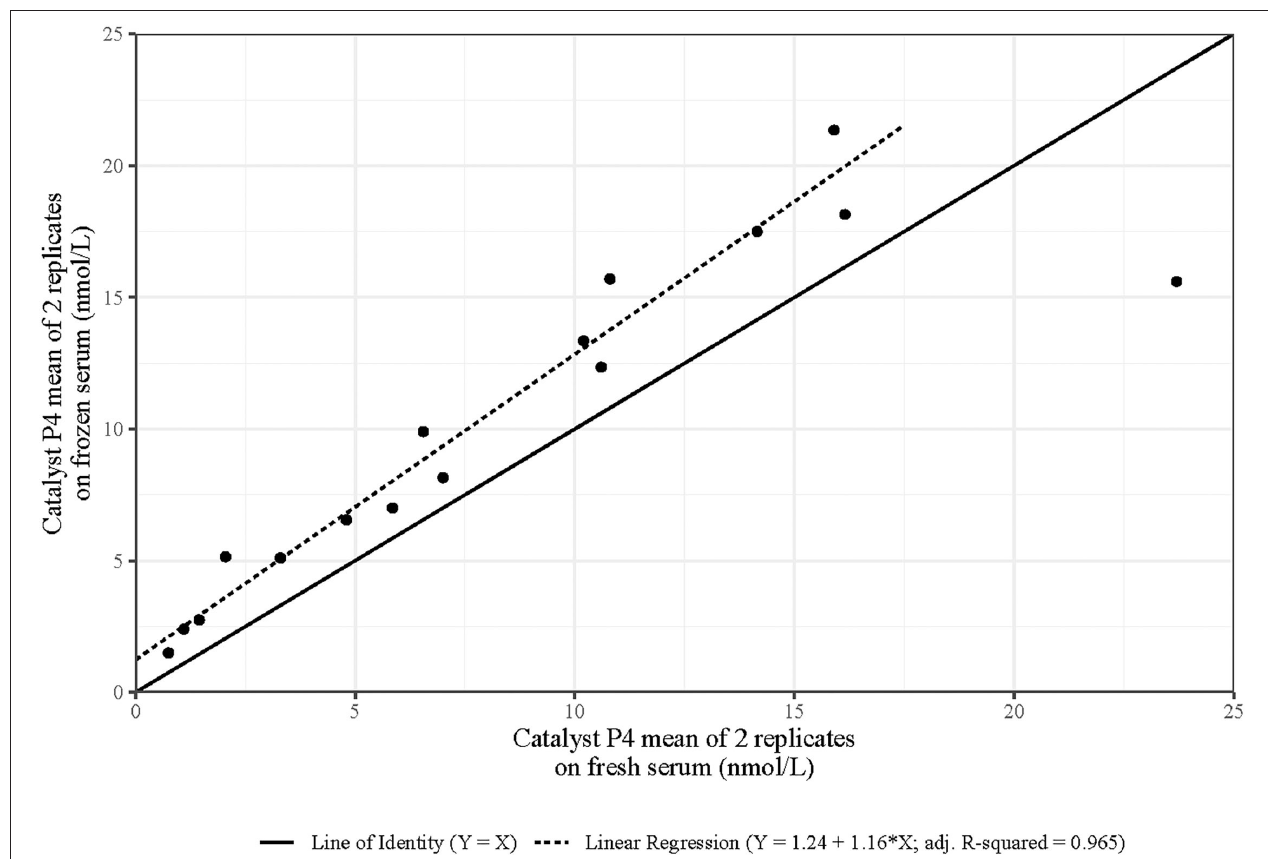
FIGURE 4 | Progesterone levels were determined using the Catalyst point-of-care assay (CatP4) paired with fresh and frozen-thawed sera. Duplicate CatP4 was determined for both the fresh and frozen-thawed aliquots. Linear regression was performed after the exclusion of the outlier.